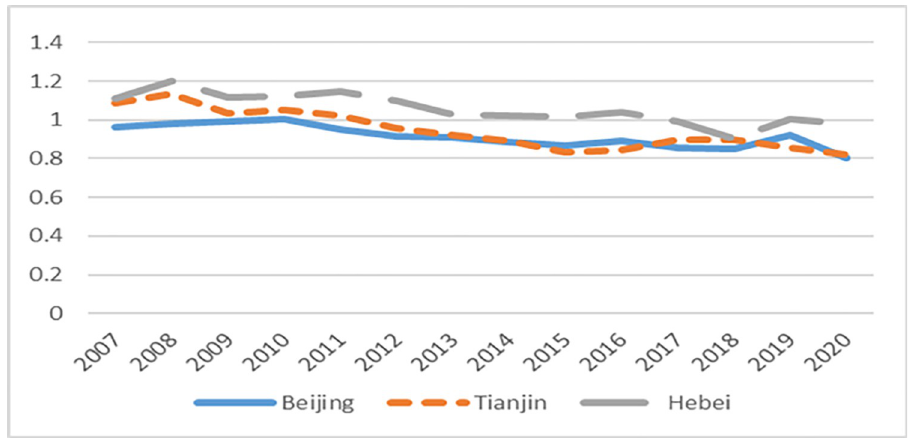
Fig 3. The trend of total factor productivity in Beijing, Tianjin and